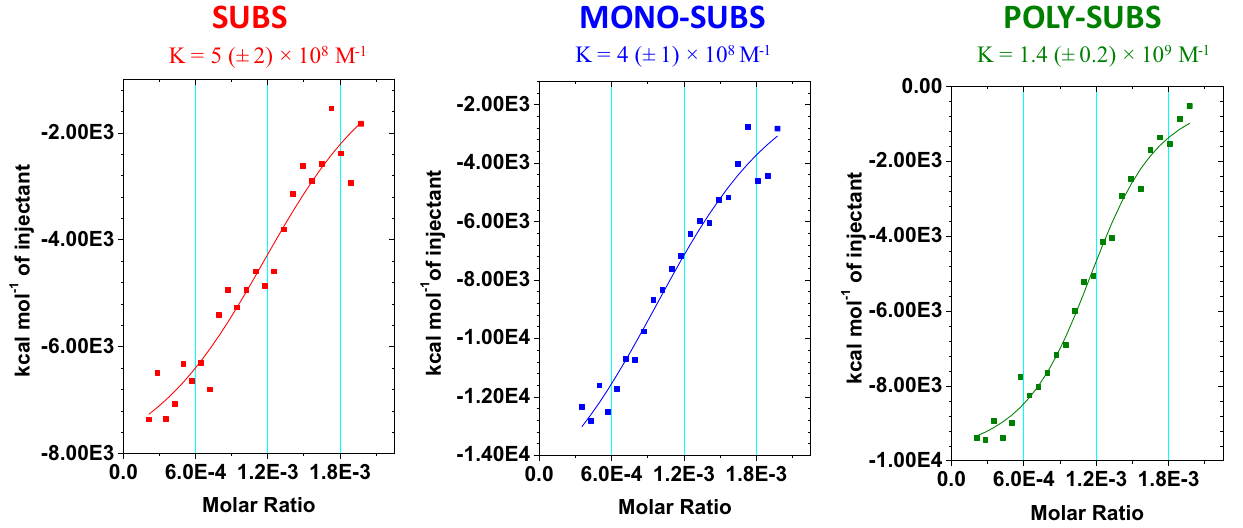
Figure 4. Study of the reaction between trypsin and three different substrates by isothermal titration calorimetry. The assays were carried out at 25.00 °C, using substrates and trypsin concentrations of 0.1 mM and 0.1 μM, respectively, in DMSO:Buffer pH7 (10:90). Graphs show the equilibrium constant with calculated